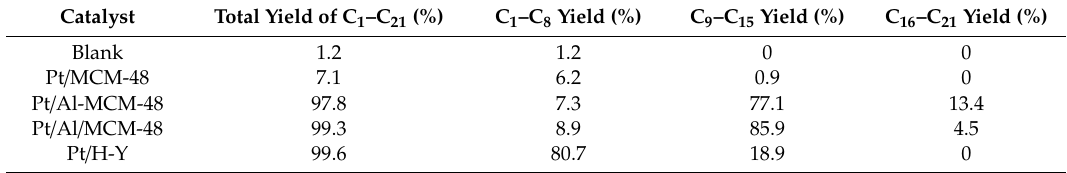
Table 2. Reaction results of polyethylene hydrocracking over various catalysts at 573 K for 4 h 1 .